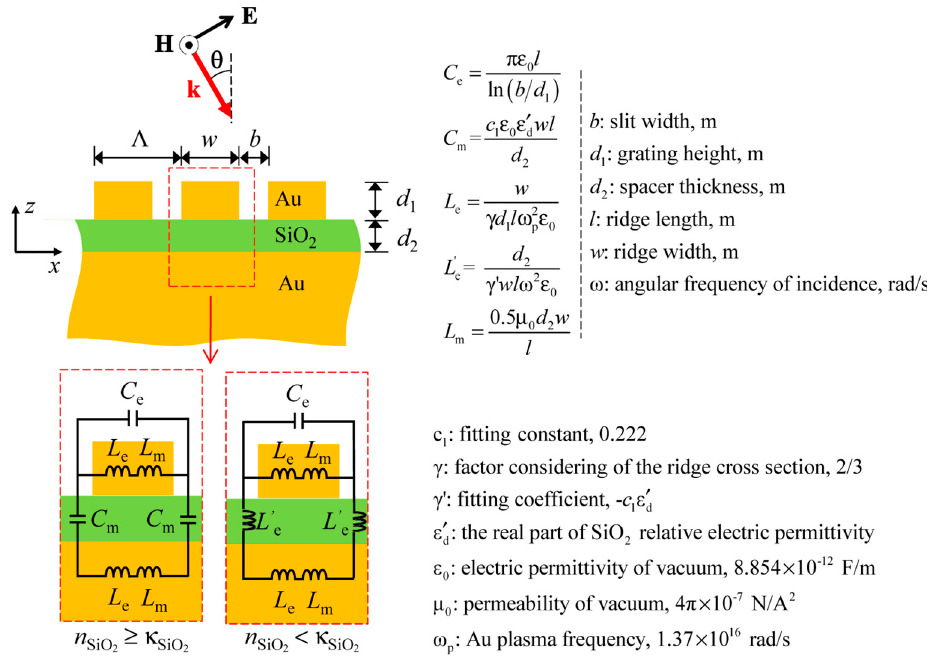
Figure 6. Schematic illustration of the LC equivalent circuit for MIM ‐ PMAs. Figures were adapted with permission from Reference [40]. © 2013 Optical Society of America.